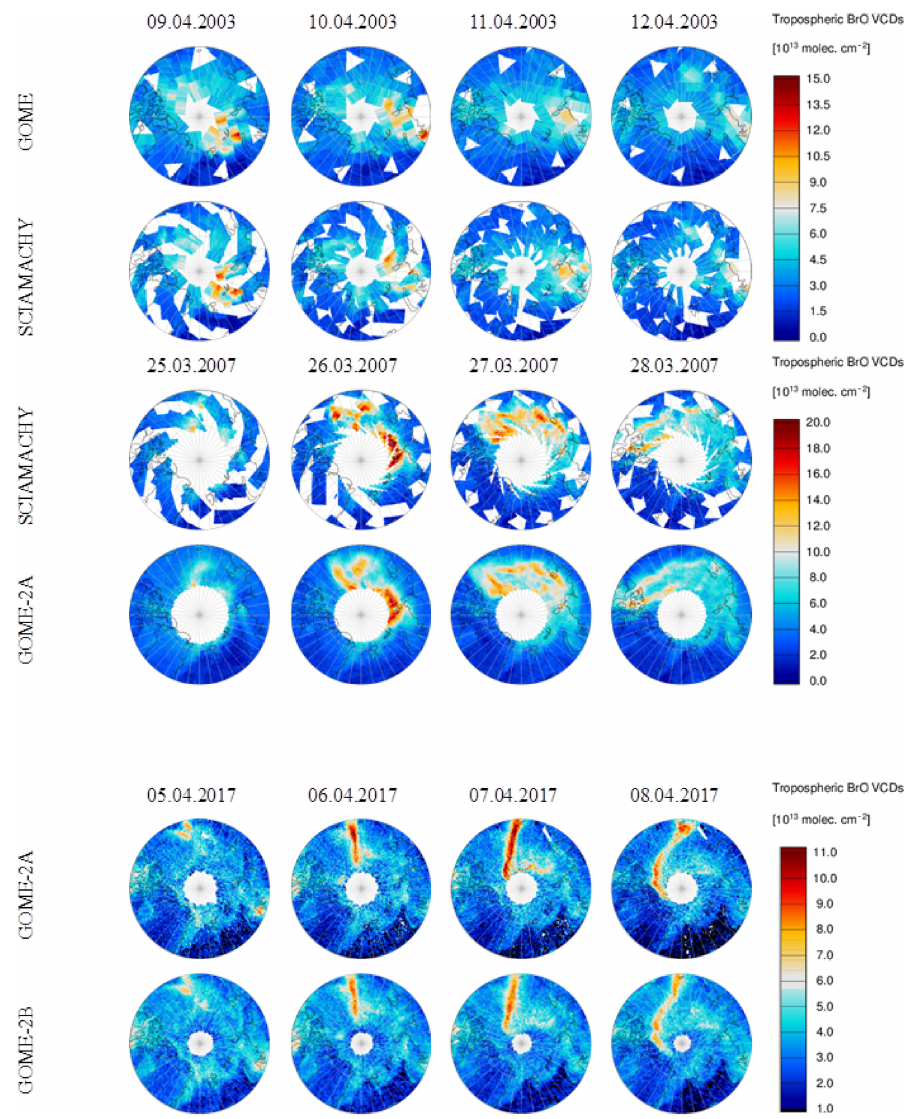
Figure 7. Examples of bromine explosion events over the Arctic region for overlapping measurement periods between the sensors. Rows refer to the different instruments, whereas columns refer to the dates. For each case, four daily average maps of tropospheric BrO VCD (10 13 moleccm − 2 ) are